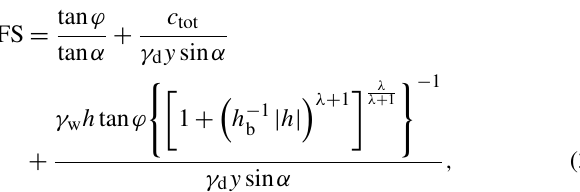
and the depth of the soil ( Z ). The solutions are obtained